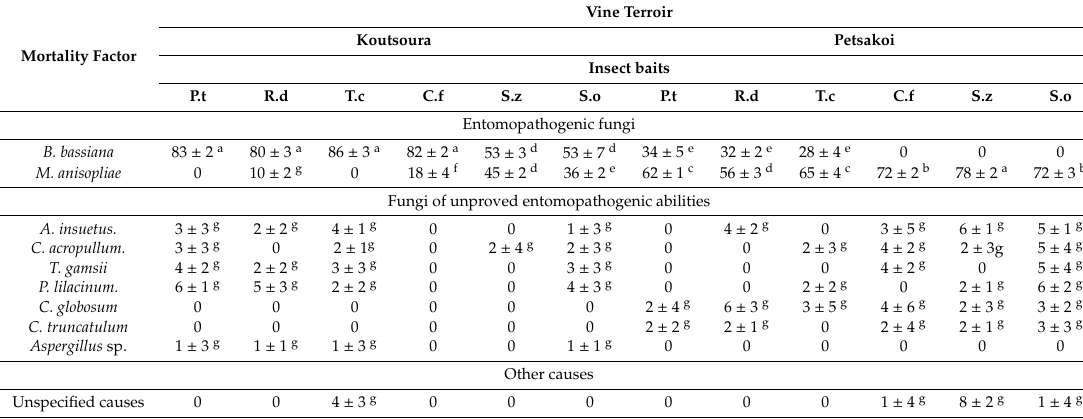
Table 1. Adult bait mortality (%) in soils from the vine terroirs in Achaia. Mean ± sd values with the same letter within a column are not significantly di ff erent (P < 0.05). P.t = P. truncates , R.d = R. dominica ,